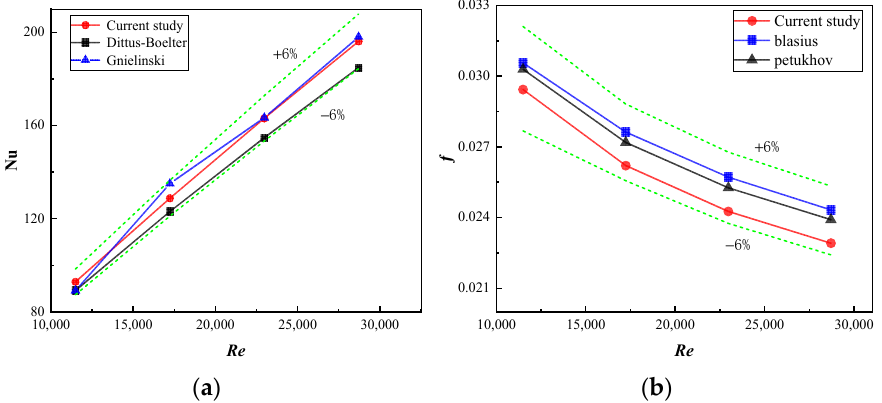
Figure 5. Validation of the numerical analysis model. ( a ) Comparison of Nu and ( b ) f between the